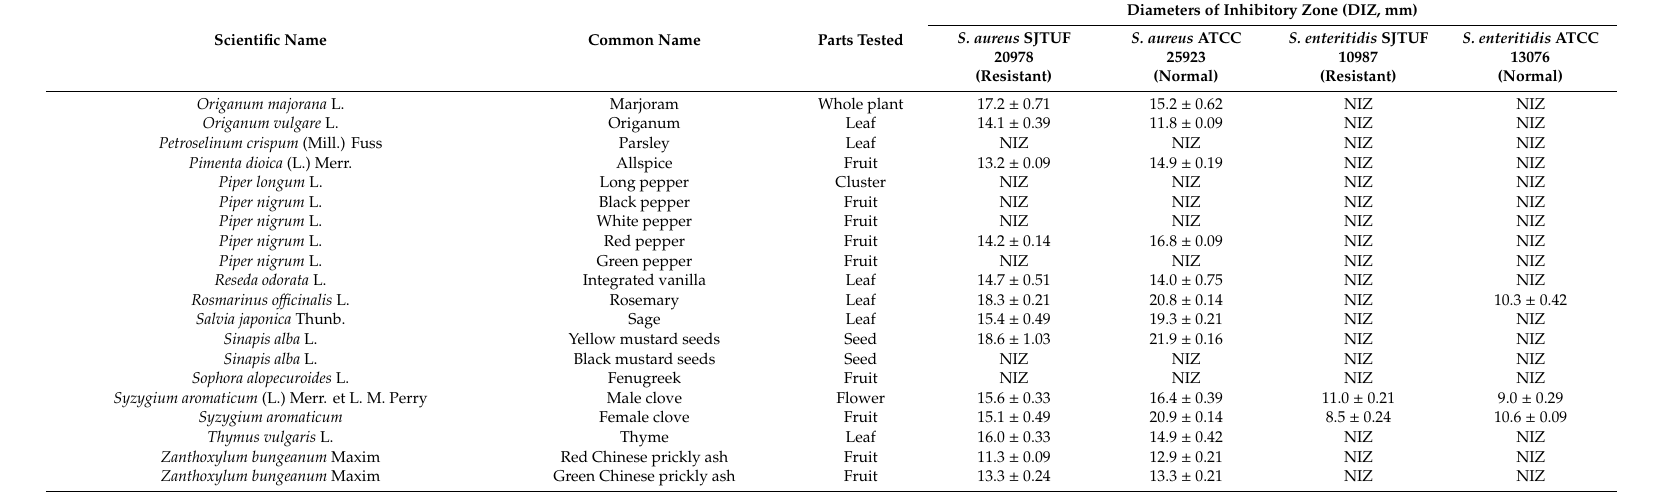
The data were averages of three measurements with standard deviation. NIZ means no inhibition